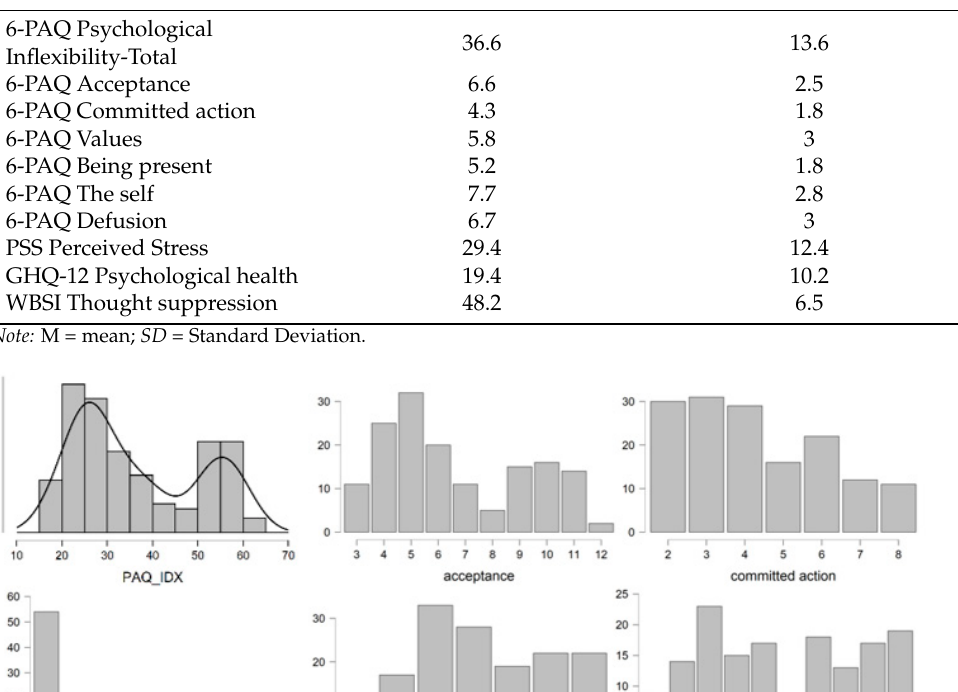
Figure 1. Distribution of the scores of 6-PAQ and its subscales. Note: PAQ_IDX: 6-PAQ total score.